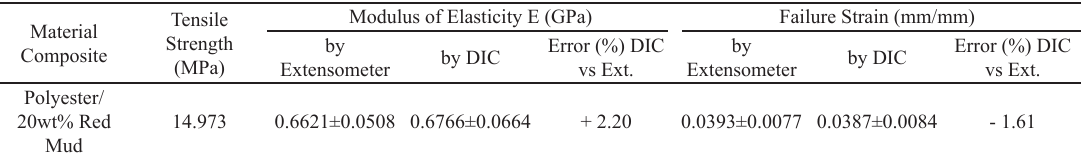
Table 4. Result of tensile tests of samples of red mud polyester composites. Material